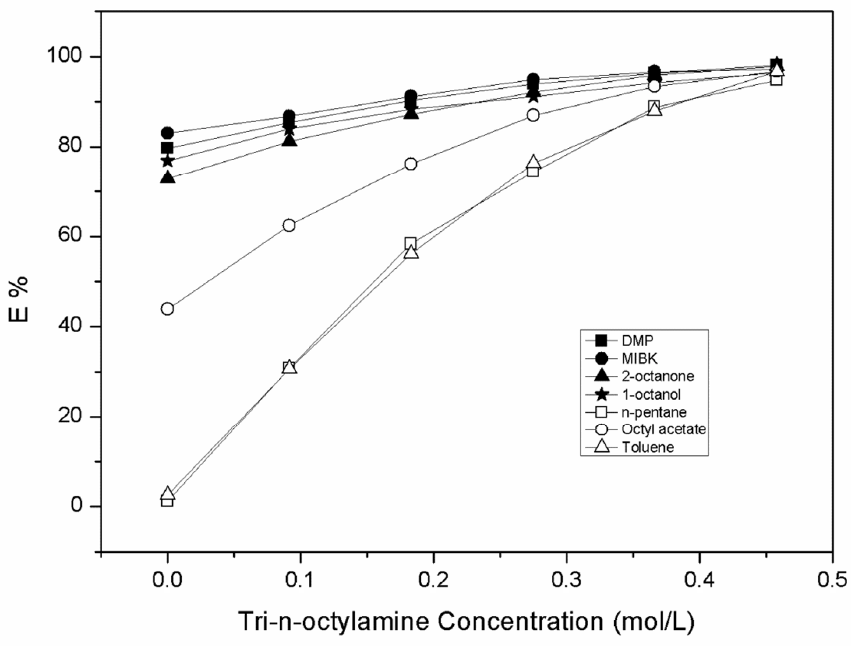
Figure 1. Plot of extraction efficiency (E) versus the molar concentration of TOA (C TOA,org ) in different diluents.